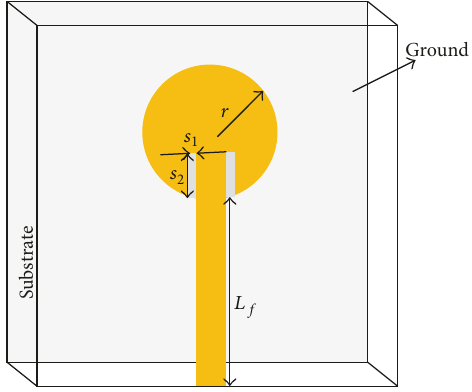
Figure 16: Geometry of the microstrip antenna.